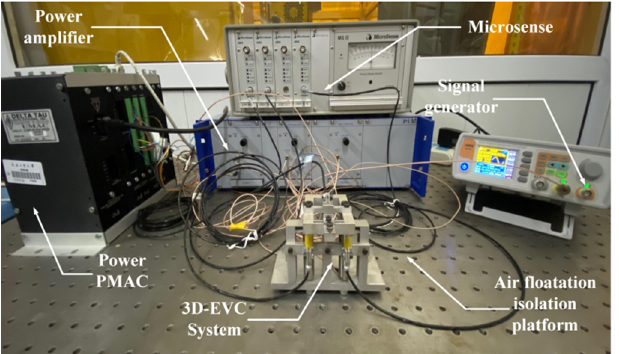
Figure 3. Experimental